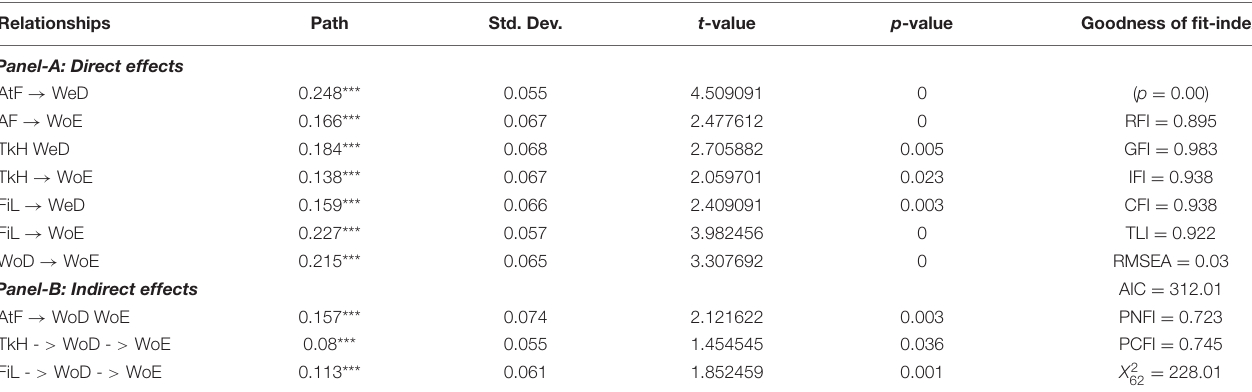
TABLE 9 | Hypothesis testing with structural